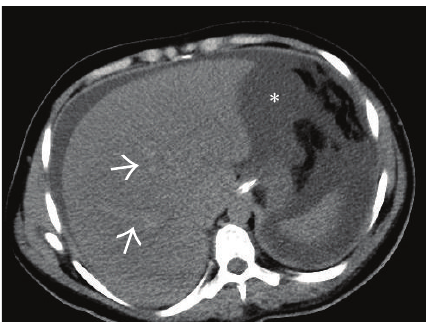
Figure 4: Noncontrast-enhanced axial CT scan image showing a diffusely hypodense liver in this patient with acute thrombosis of all the three hepatic veins. On careful inspection, the right and middle hepatic veins can be made out as mildly hyperdense structures (arrows) on the background of this hypodense liver. Ascites can also be seen on this section (asterisk).